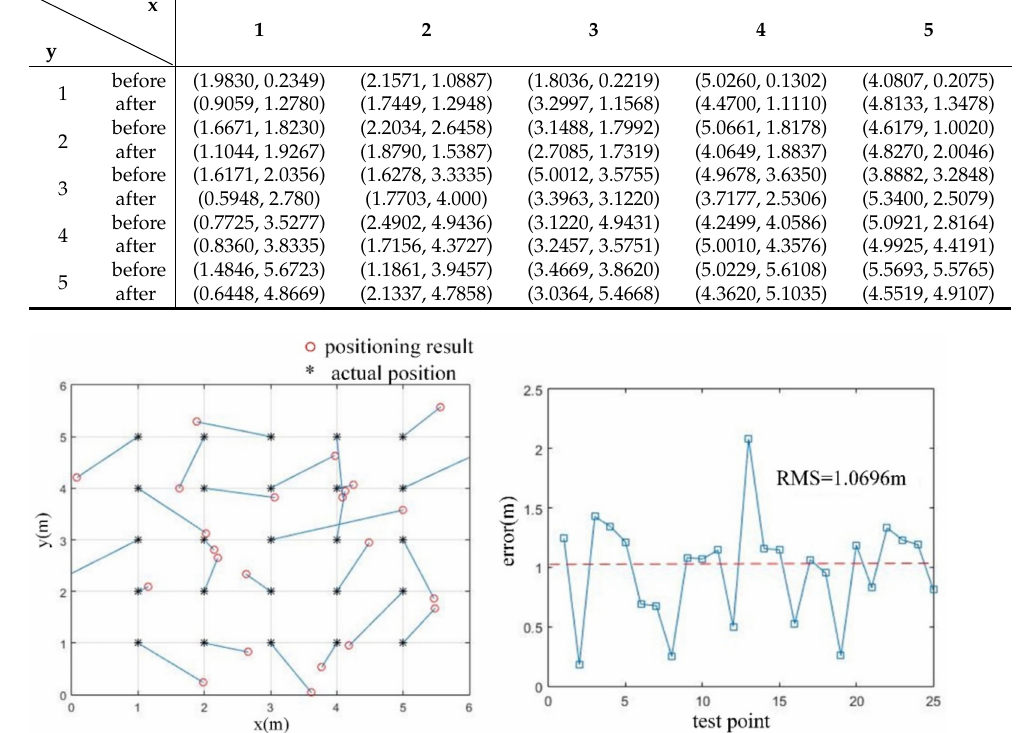
Figure 10. ANN test results without deterministic simulation input.